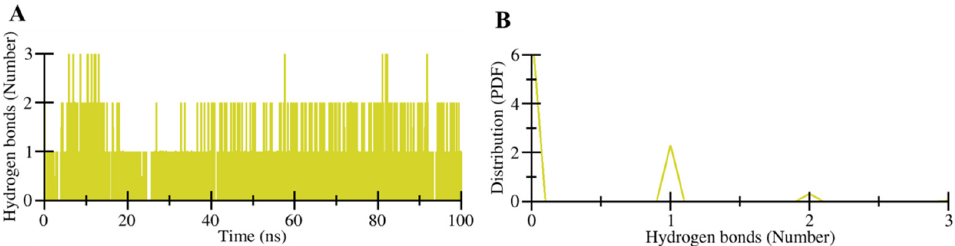
Figure 6. Intermolecular hydrogen bonds during the simulation. ( A ) Time evolution of hydrogen bonds formed between HpzA and HSA. ( B ) The probability of distribution of hydrogen